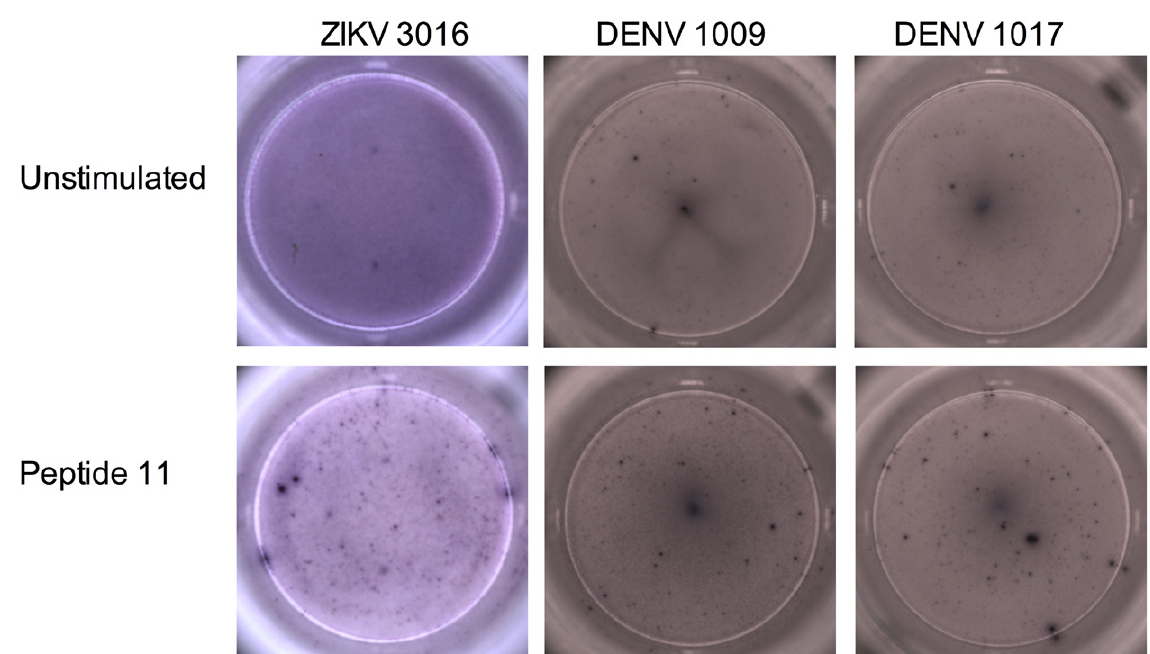
Supplementary Figure 3. IFNgamma ELISPOT results for unstimulated PBMCs (top row) or stimulated with peptide 11 (lower